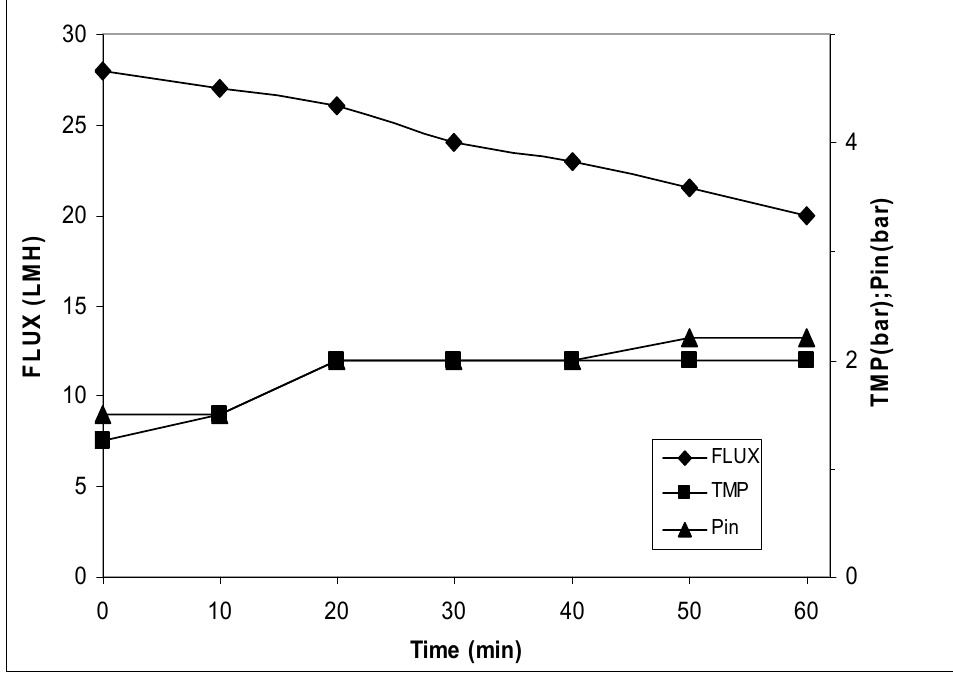
Figure 3. Transmembrane flux, corresponding transmembrane pressure (TMP), and inlet pressure during ultrafiltration treatment. The experiments were performed in triplicate.